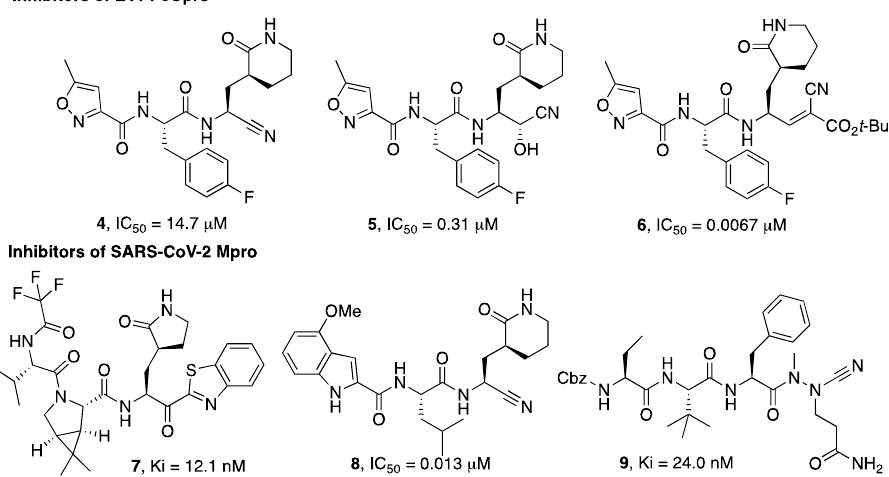
Figure 2. Chemical structures of viral cysteine proteases inhibitors 4 – 6 (EV71 3Cpro) and 7 – 9 (SARS-CoV-2 Mpro).